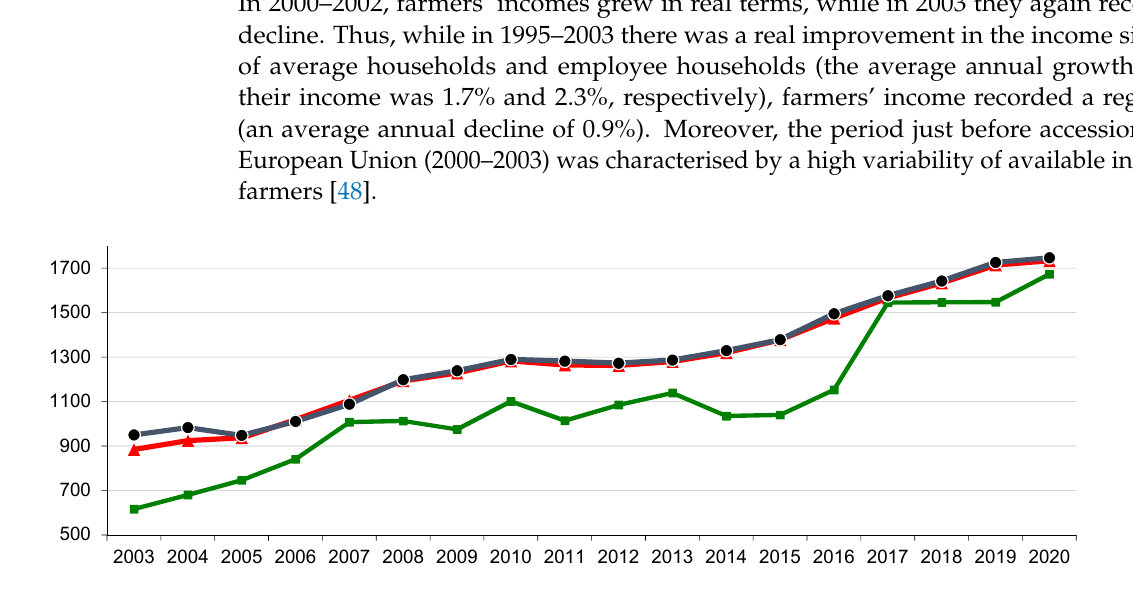
Figure 1. Real available income per capita in farmers’ households and in total households and employees in 2003–2020 (in PLN) This is a figure. Schemes follow the same formatting. Source: own study based on Household Budget Survey in 2003 and next until 2020; Central Statistical Office: Warsaw, 2004–2021.